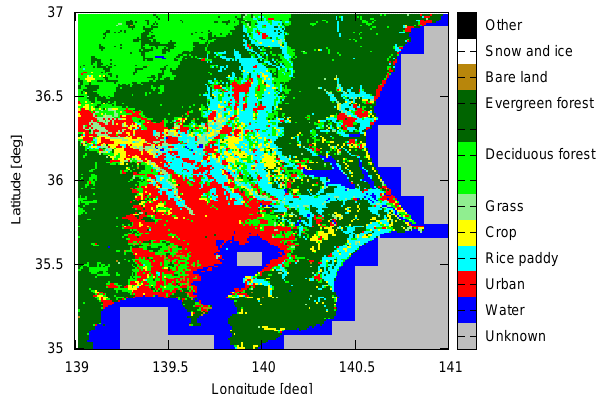
Figure 3. Land cover type map over the Kanto Plain derived from AVNIR-2. The grid size is changed to a 1km square, which is the MODIS pixel size, from the AVNIR-2 original size of a 50m Fig. 3. Land cover type map over the Kanto plain derived by AVNIR-2. The grid size is changed to a 1 km square. square, which is the MODIS pixel size, from the AVNIR-2 original size of a 50 m square.